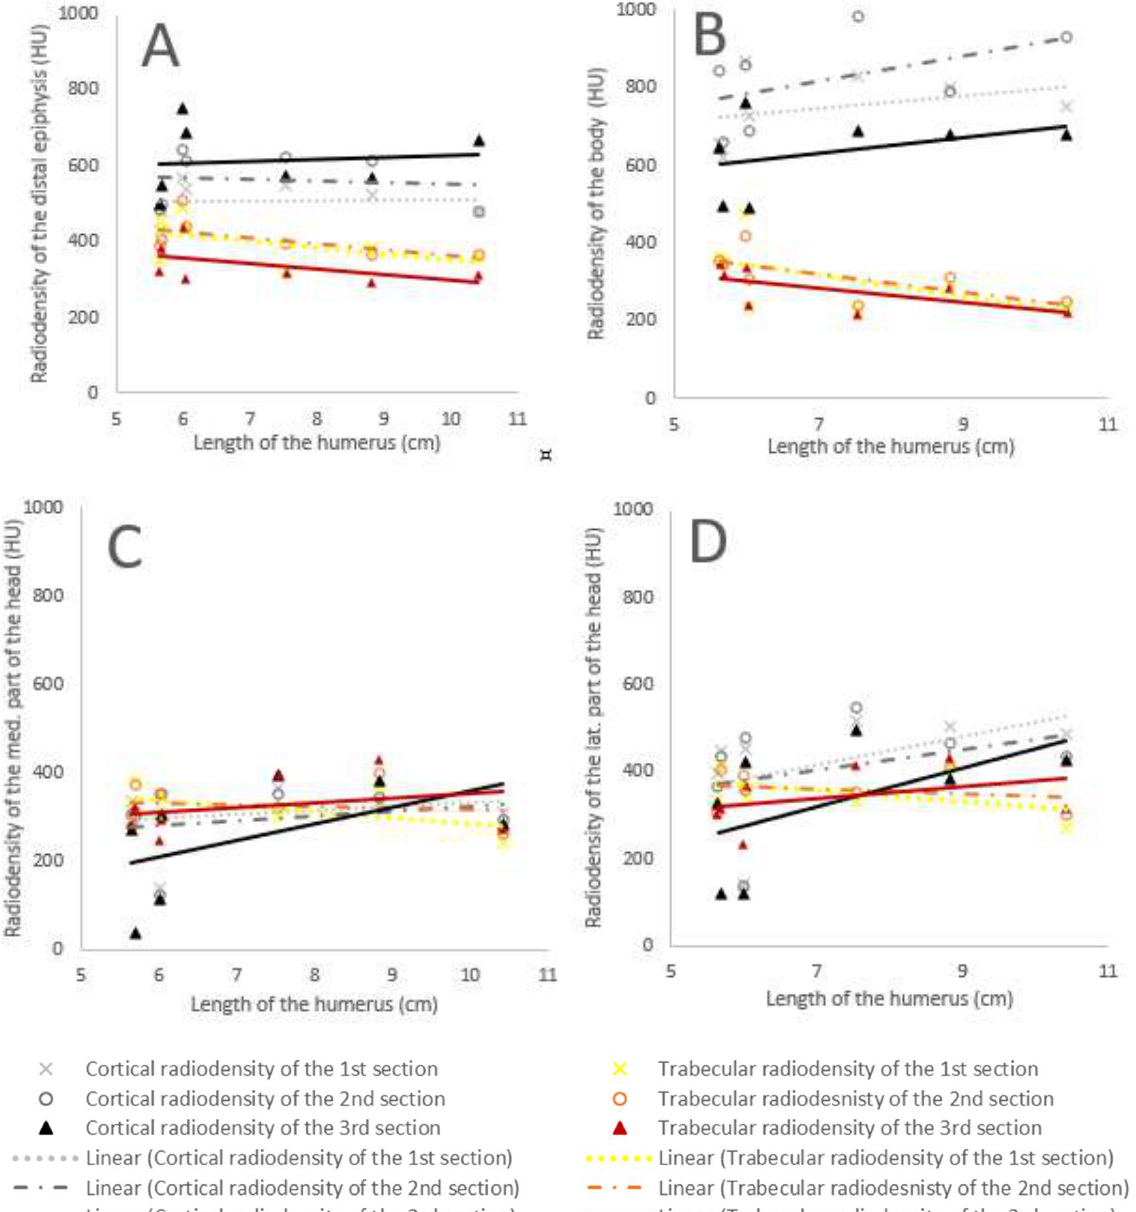
Figure 3. The graphs show differences in radiodensity with humeral length in the pigmy sperm whales: ( A ) the humeral distal epiphysis, ( B ) the humeral body, ( C ) the medial aspect of the humeral head, and ( D ) the lateral aspect of the humeral head. Black and grey lines represent cortical bone density values (CD), while the red, orange, and yellow lines represent trabecular bone density values (TD). Dotted lines represent the regression lines for the first section, dashed lines are for the second section, and the continuous line depicts the third section.